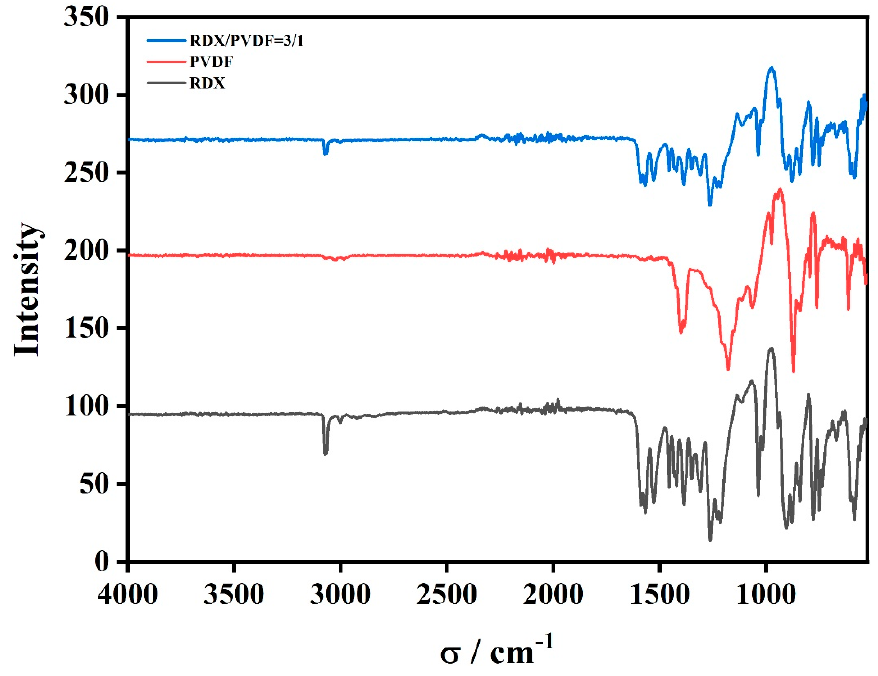
Figure 3. FTIR spectra of raw RDX and RDX@PVDF microspheres.